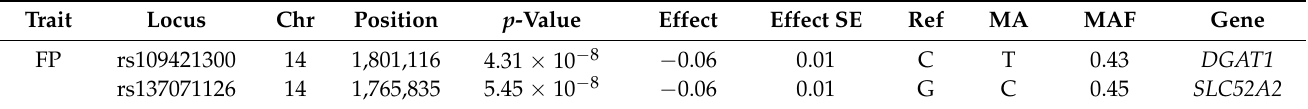
Table 5. The single nucleotide polymorphisms (SNPs) which reached significance in single-locus association for fat percentages at genome-wide threshold ( p < 1 × 10 − 6